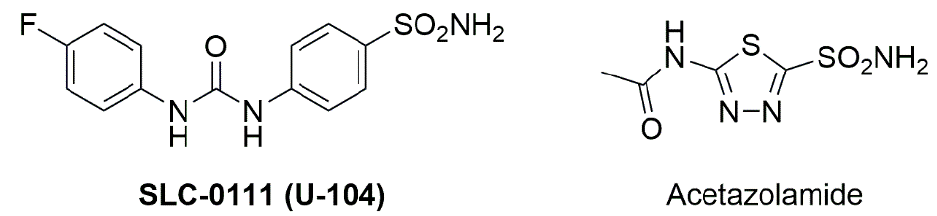
Figure 1. Structure of well-established CA inhibitors SLC-0111 and acetazolamide.